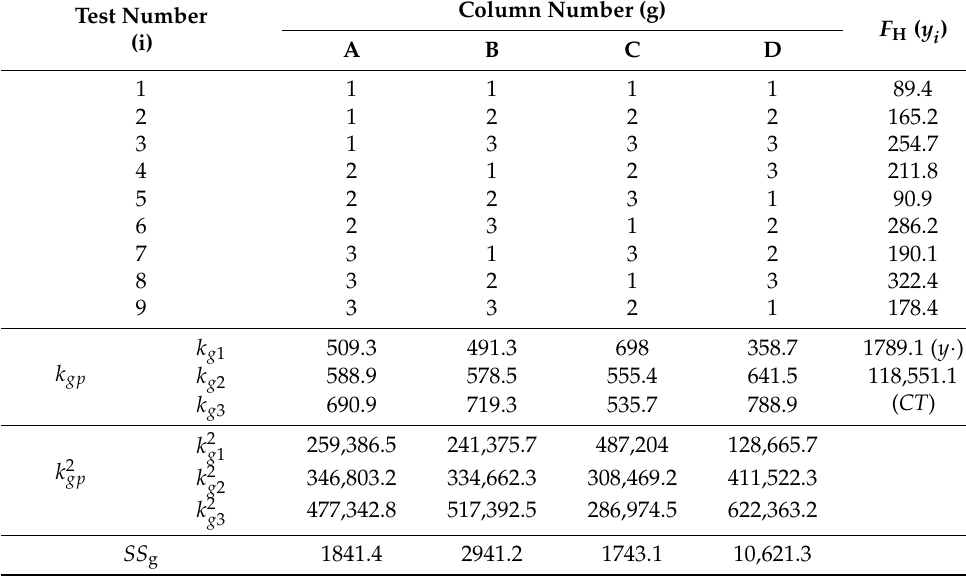
Table 5. Data processing results of the cutting force in the cutting direction.